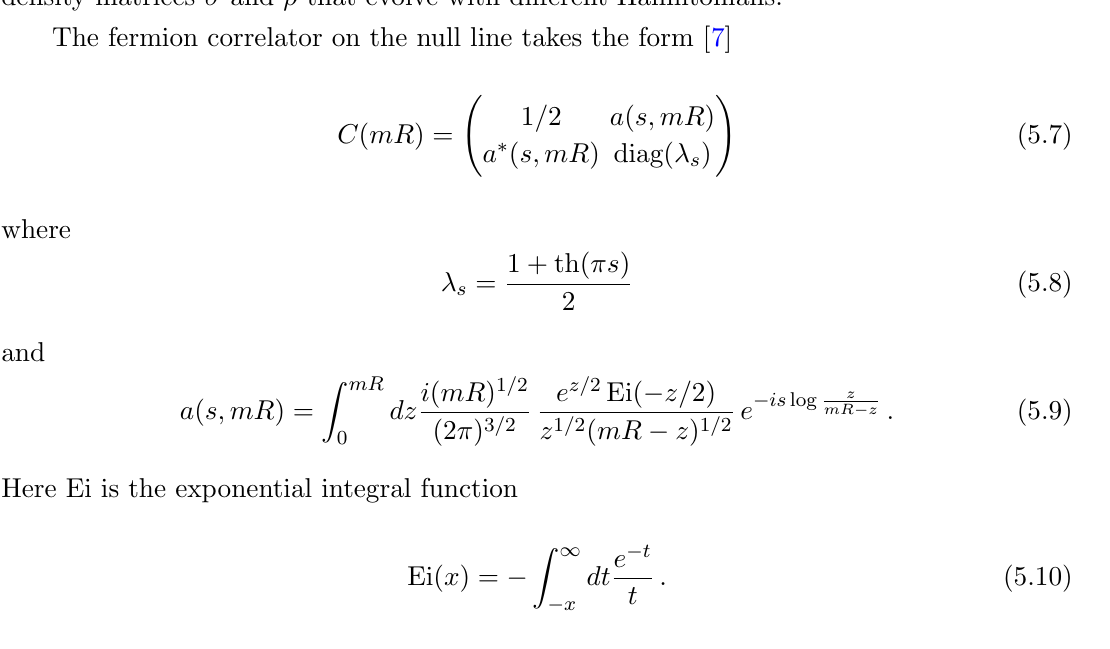
general discussion in section 4.1, this should give (cid:12)nite QRREs as mR (cid:29) 1. The